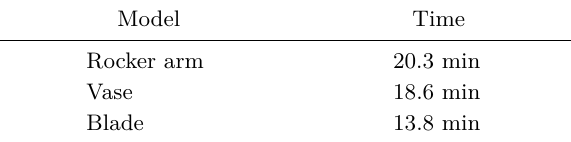
Table 2 Timings for our